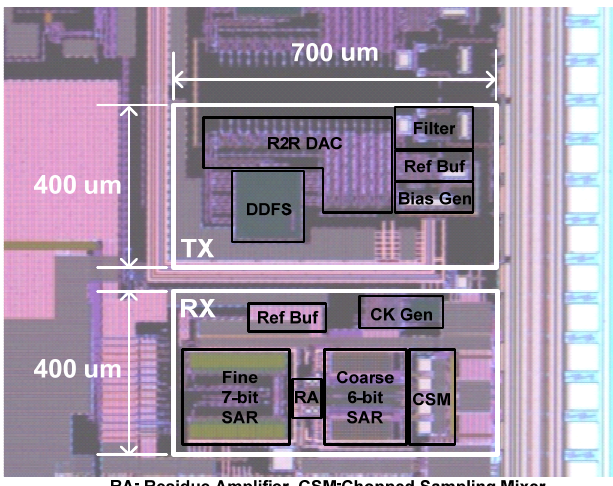
Figure 7. Die photograph of our EIS SoC.